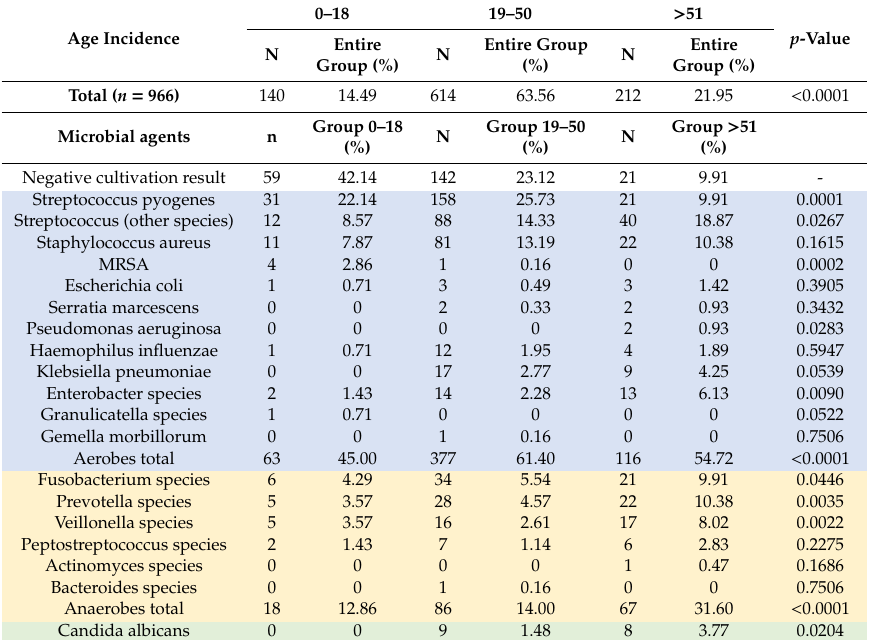
Table 3. The spectrum of microbial agents based on age.